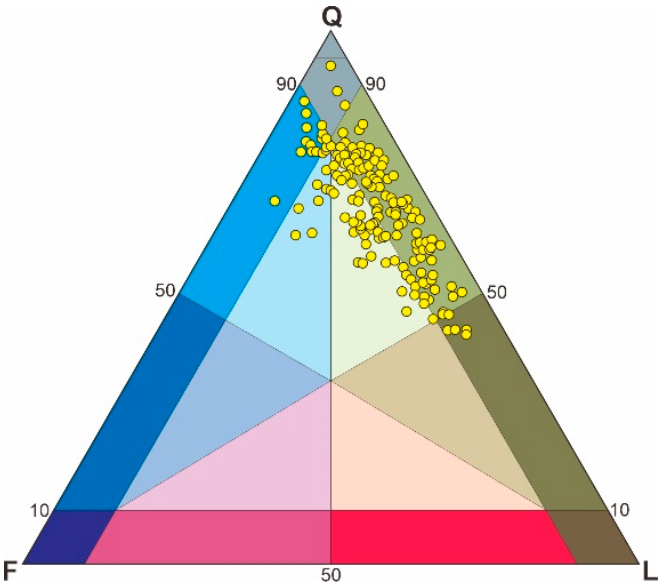
Figure 6. Detrital composition triangular diagram of the beach-bar sandstones in the Weixinan sag [34]. The detrital composition of beach-bar sandstones are mainly litho-quartzose and feldspatho- litho-quartzose sandstones. Heavy minerals in the study area are mainly zircon, tourmaline, rutile, garnet, hematite, limonite, magnetite and titanomorphite. The zircon contents are between 0.2% and 20%, with an average value of 5.2%. The percentage of tourmaline varies from 0.2% to 27.6%, and the average value is 4.5%. Rutile has an average content of 0.82%, ranging from 0.2% to 2.9%. The garnet content varies from 0.2% to 19.4% with an average of 3.2%. Hematite and limonite have the highest contents. They account for an average of 61.2% of the total heavy minerals, varying from 1% to 97.8%. Magnetite and titanomorphite have average values of 5.7% and 19.9%, fluctuating between 0 and 30.8%, and between 0.2% and 91.6%, respectively (Figure